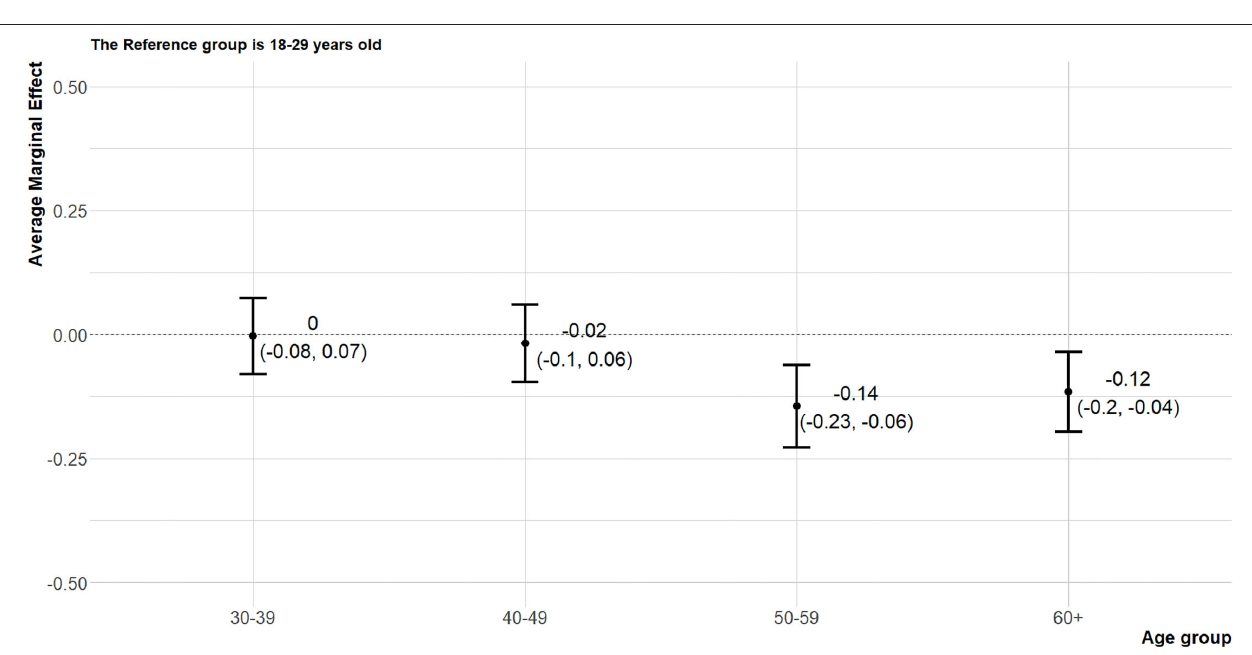
away from one’s political orientation group. Considering the survey timing when the approval rating for the ruling party was very high due to the successful COVID-19 response, this group might be conservative but have some difficulty expressing their political stance. The combined proportion of